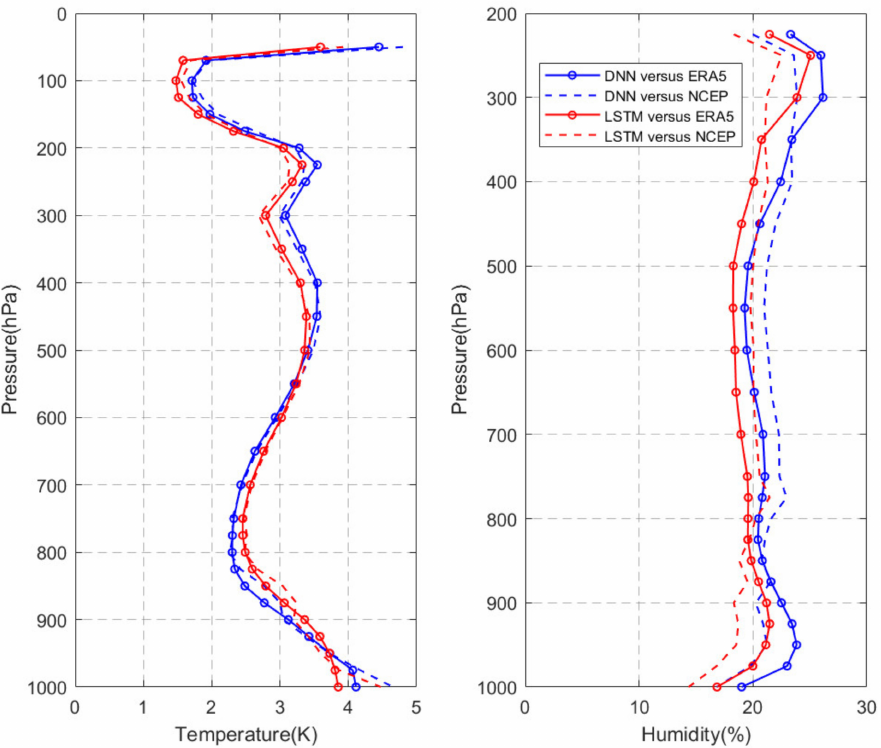
Figure A3. The retrieval RMSEs of the DNN-based model and the LSTM-based model with respect to ERA5 and NCEP reanalysis data over land in April 2021.